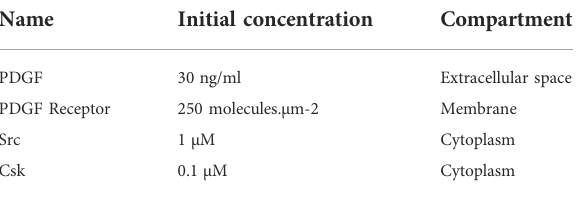
TABLE2 Initialconcentrationsfor modeling Srcactivation uponPDGF stimulation (Rangamani et al.,